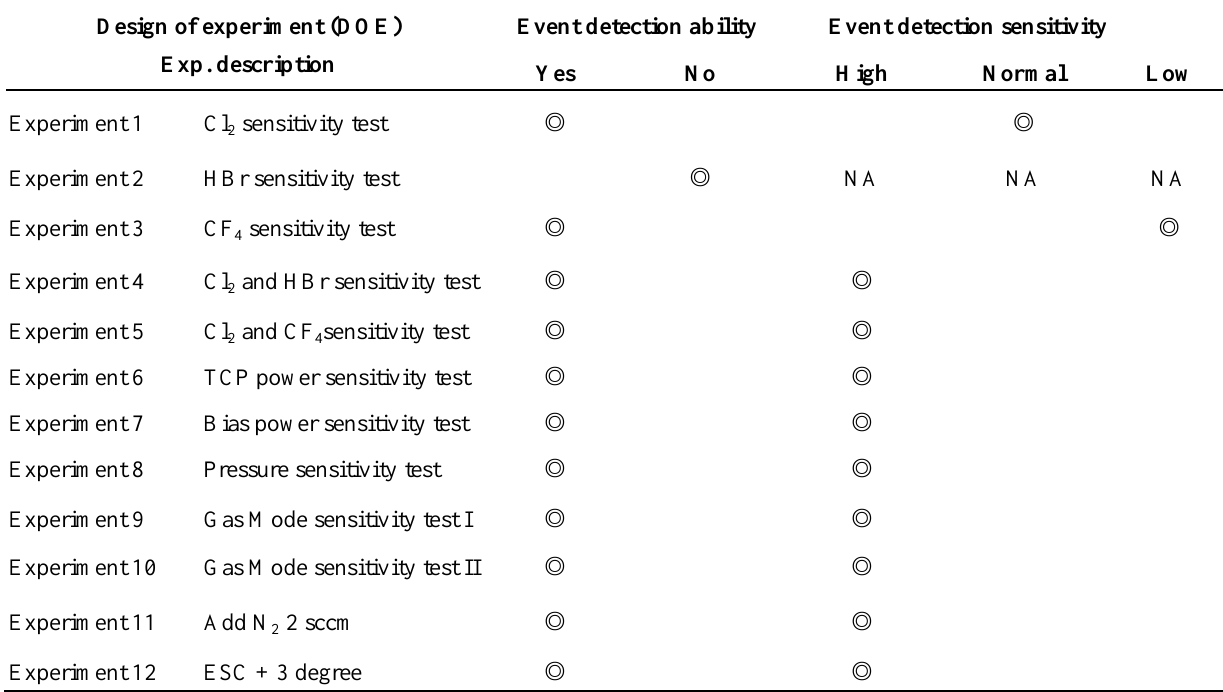
Table 2. Summary table for detection capability of